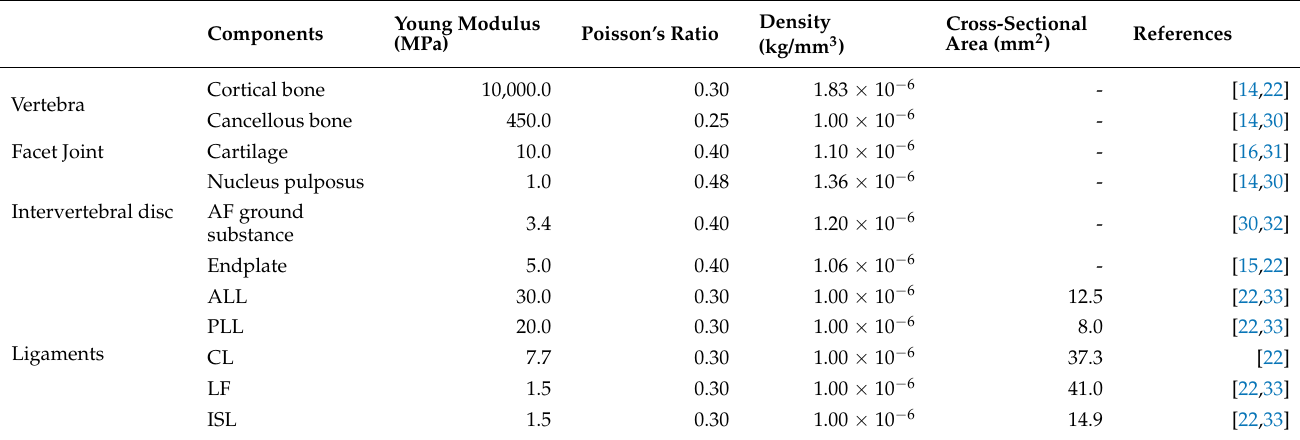
Table 1. Material properties used for the cervical spine model.